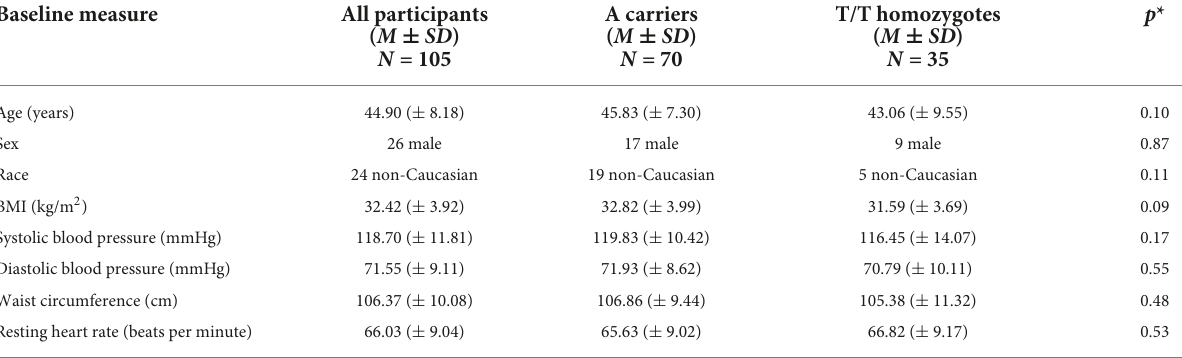
TABLE 1 Baseline comparisons of FTO T Homozygotes and A Carriers.